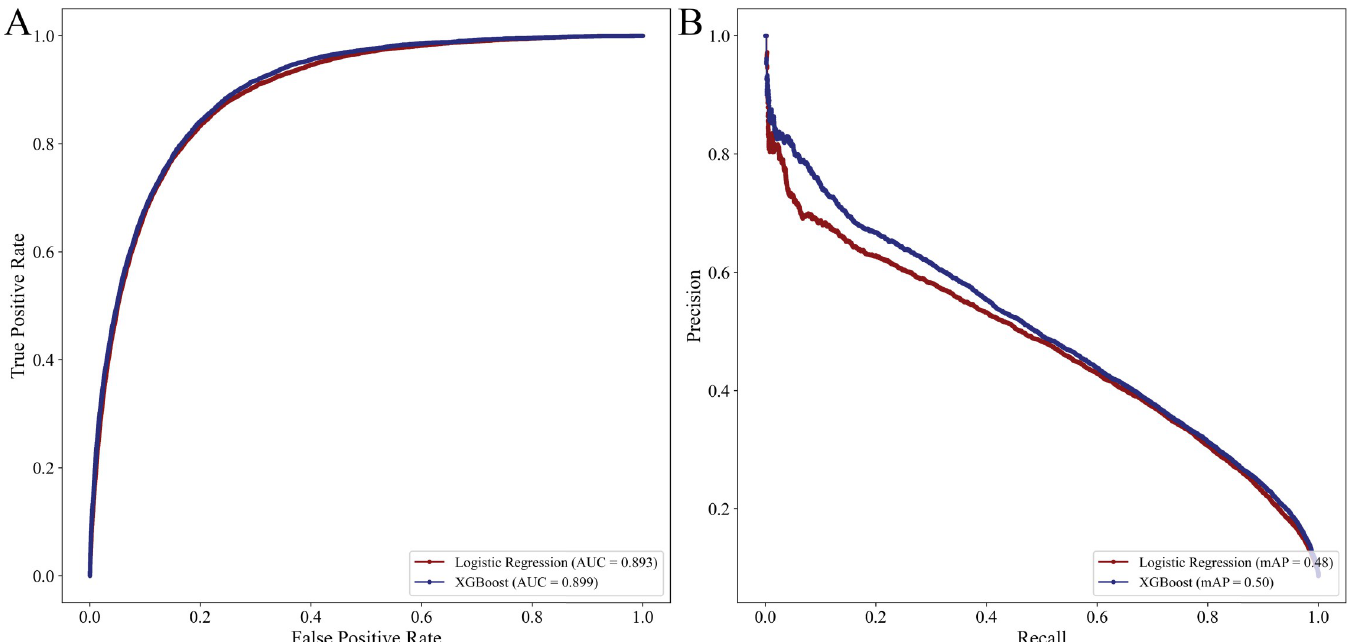
Fig 2. Receiver operating characteristics (2A) and precision recall curves (2B) for logistic regression and XGBoost with complete set of